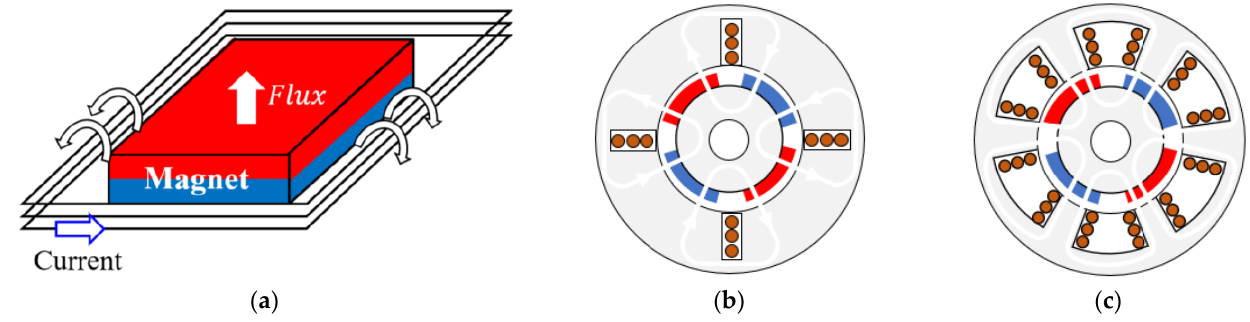
Figure 3. PMSG magnetization methods: ( a ) single component, ( b ) yoke, ( c ) stator.